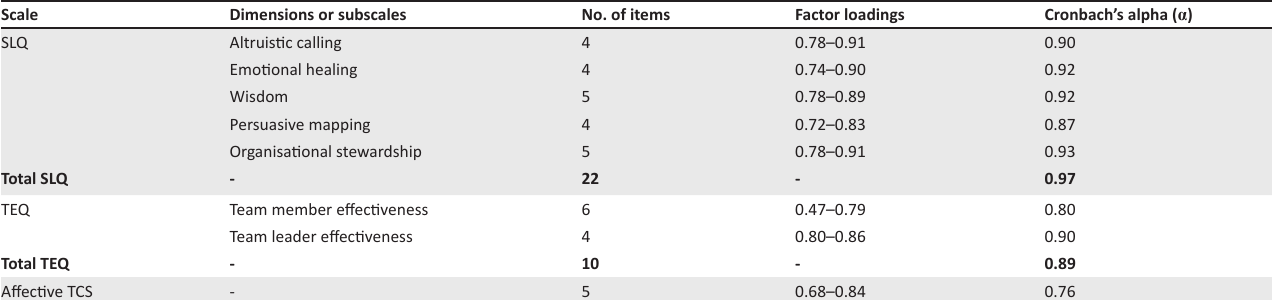
TABLE 2: Refined measurement scales: Factor loadings and reliability.